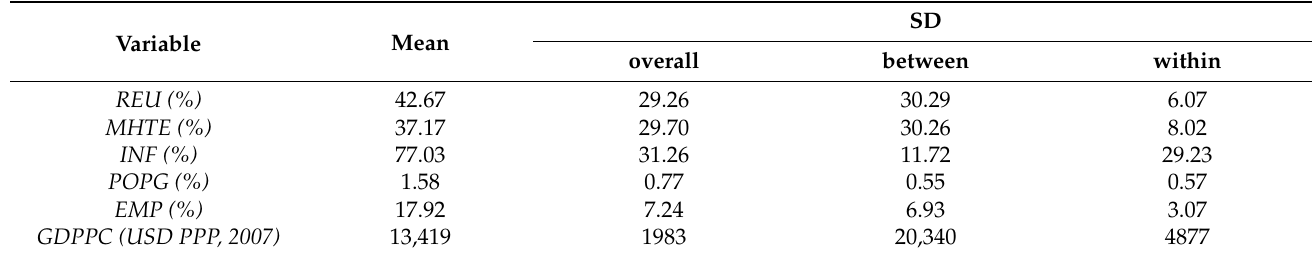
Table 2. Descriptive statistics of variables of nine ASEAN countries